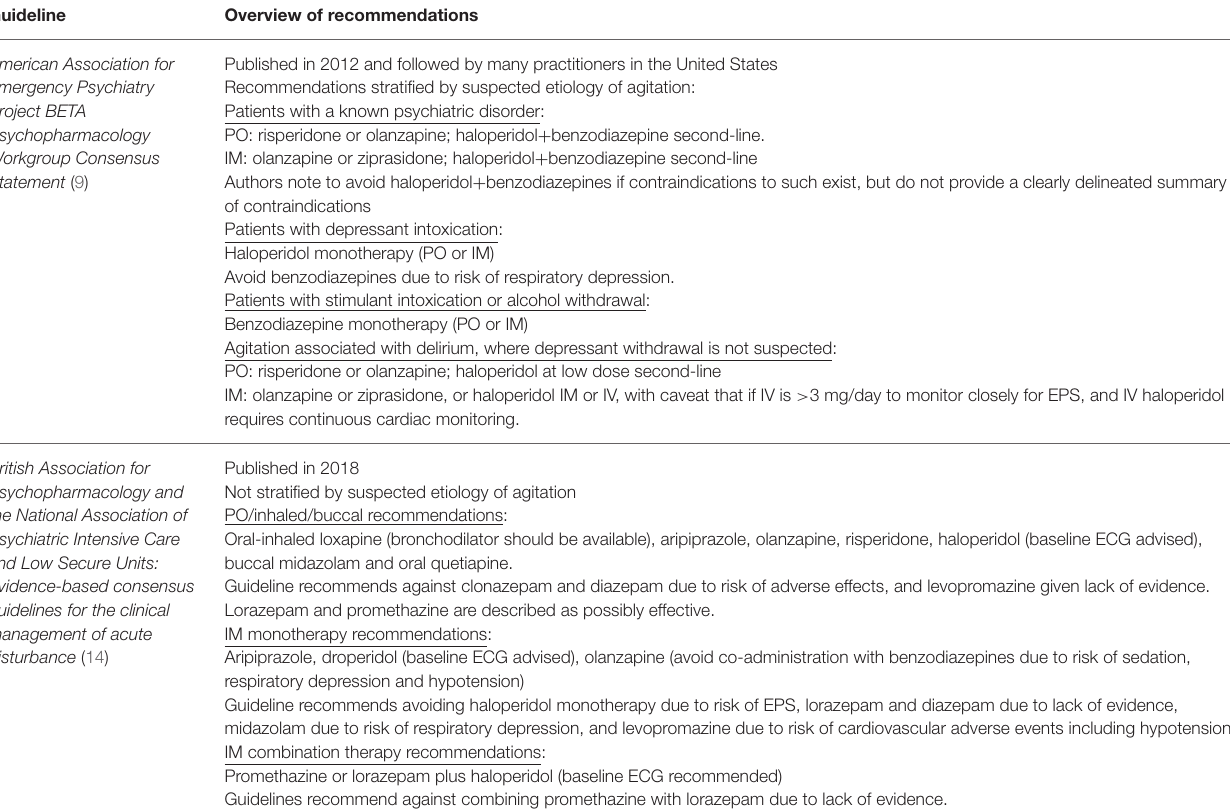
TABLE 1 | Guidelines and consensus statements regarding pharmacologic interventions for agitation.